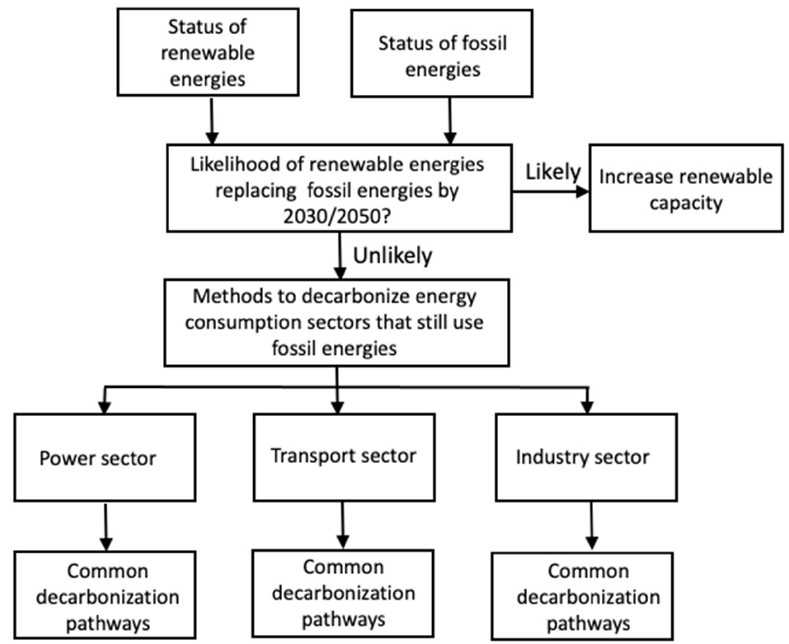
Figure 2. Methodology of study .